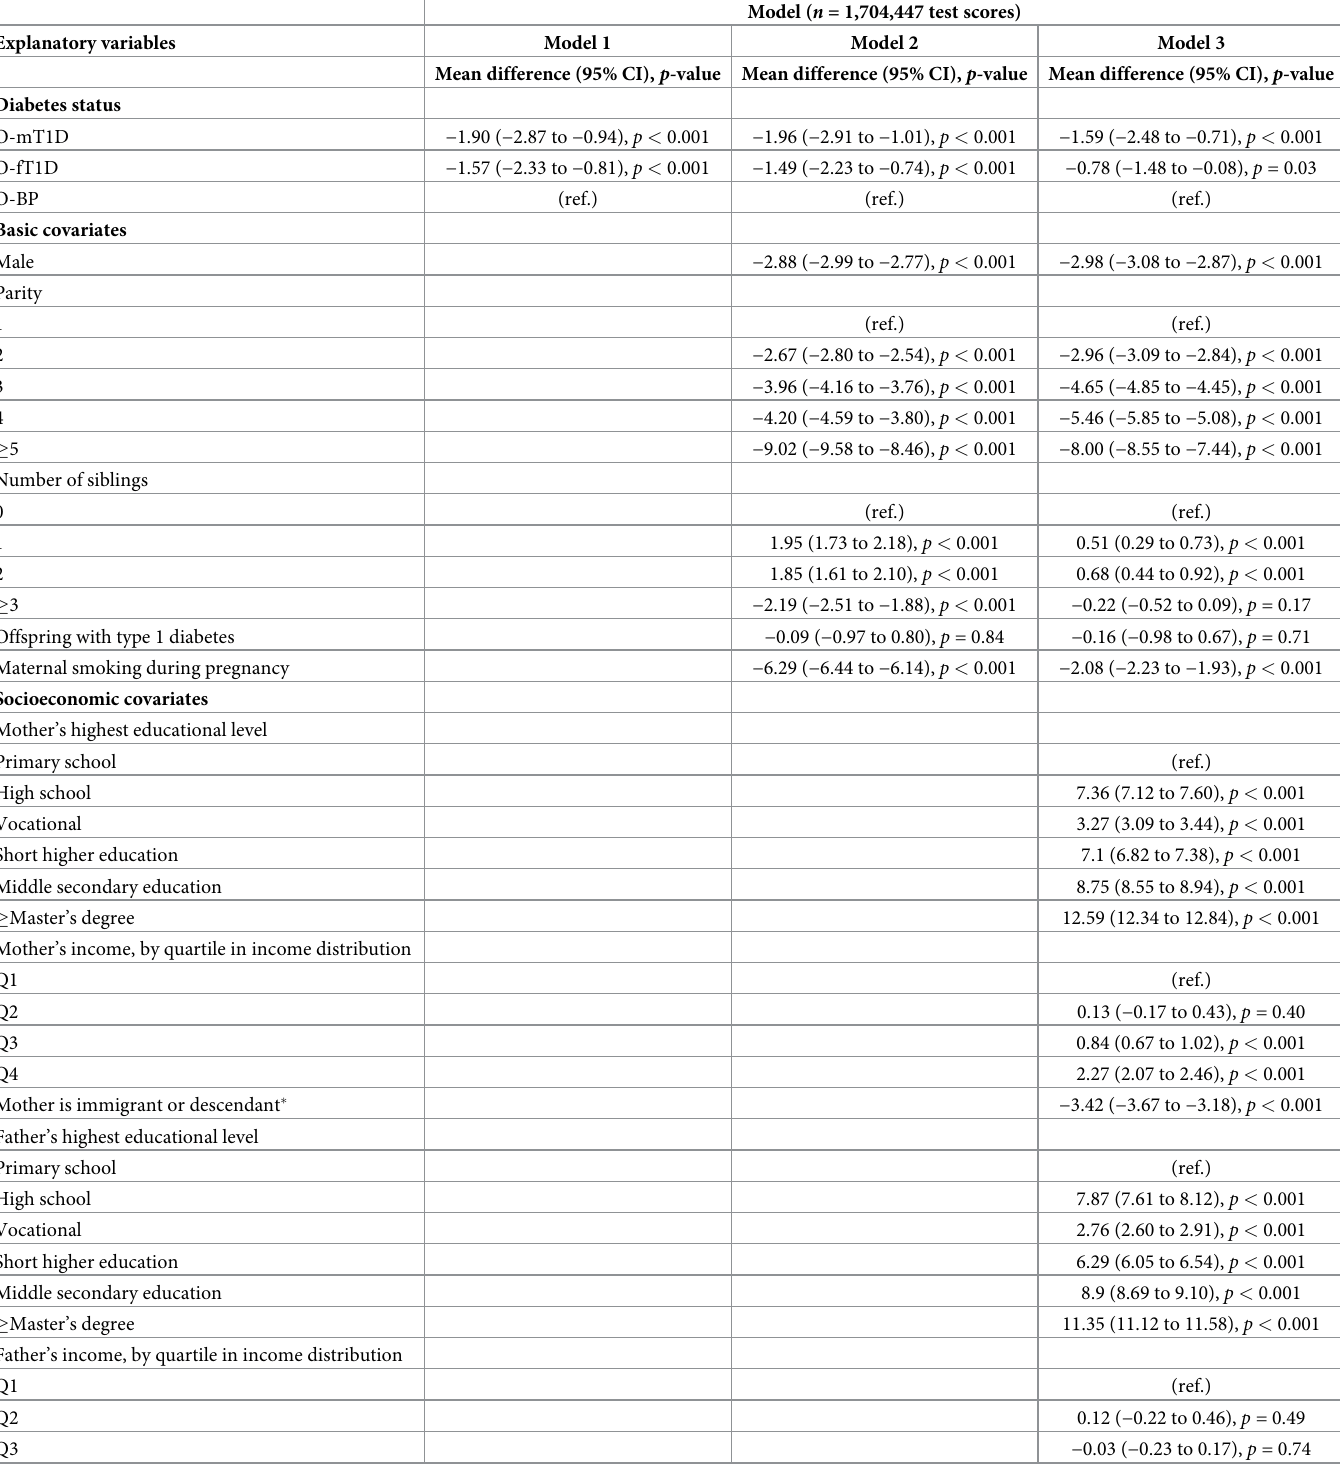
Table 2. Multiple linear regression analyses comparing test scores in offspring of mothers (O-mT1D) and fathers (O-fT1D) with type 1 diabetes compared with O-BP, mean test score difference (95%